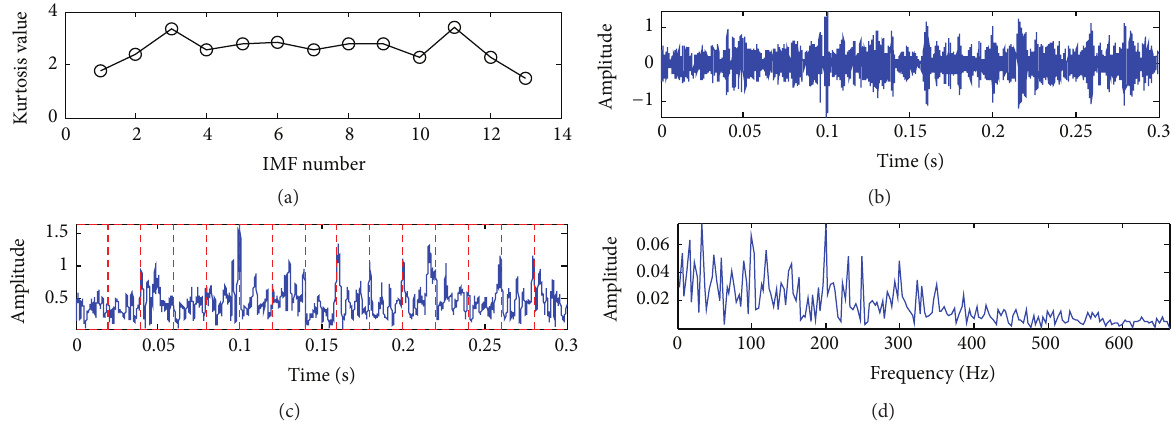
Figure 6: Analyzed results of the simulated signal shown in Figure 2(b) by the EMD-based demodulation method: (a) kurtosis curve of 13 decomposed IMFs; (b) waveform of IMF3; (c) envelope waveform of IMF3; (d) envelope spectrum of